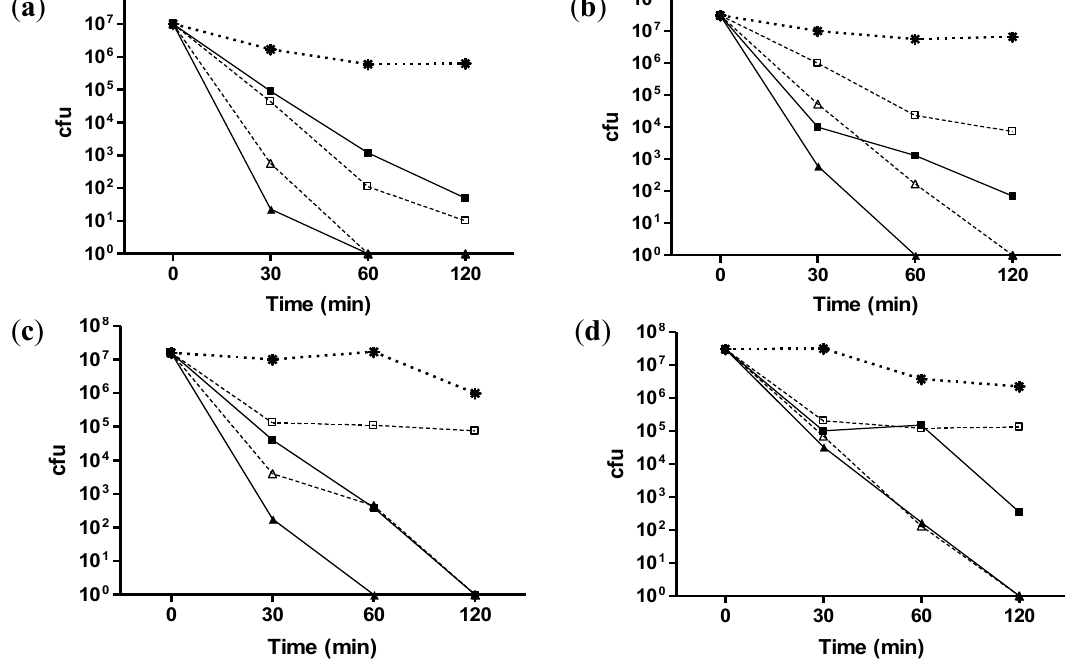
Figure 2. Time-kill curves with CuAL42 and CuPC33 on ( a ) CagA − ; ( b ) CagA + ; ( c ) metronidazole-resistant and ( d ) clarithromycin-resistant H. pylori strains. Star, control; closed square, CuAL42 5 mg/L; closed triangle, CuAL42 12 mg/L; open square, CuPC33 5 mg/L; open triangle, CuPC33 12 mg/L. The results shown are the means of triplicate observations. Error bars representing standard deviations (less than 10%) are not shown for reasons of